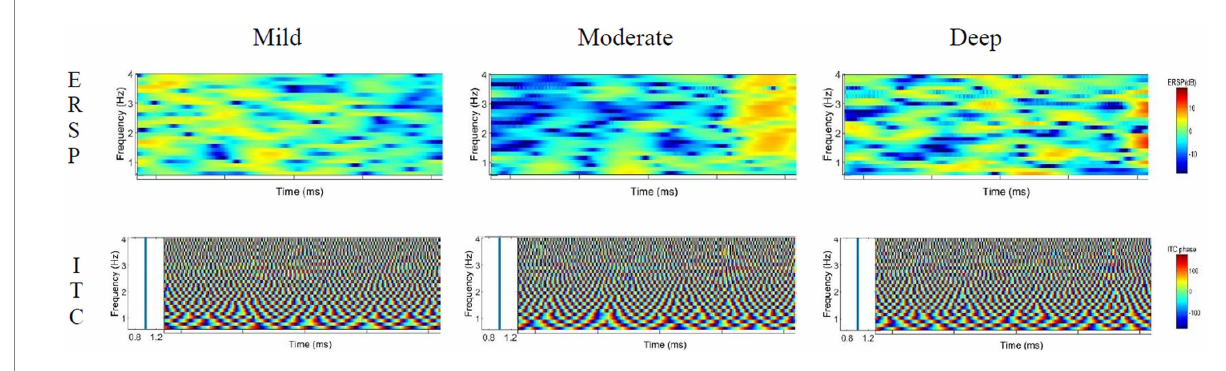
FIGURE 9 ERSP and ITC characteristics of delta wave under different cognitive workload events.